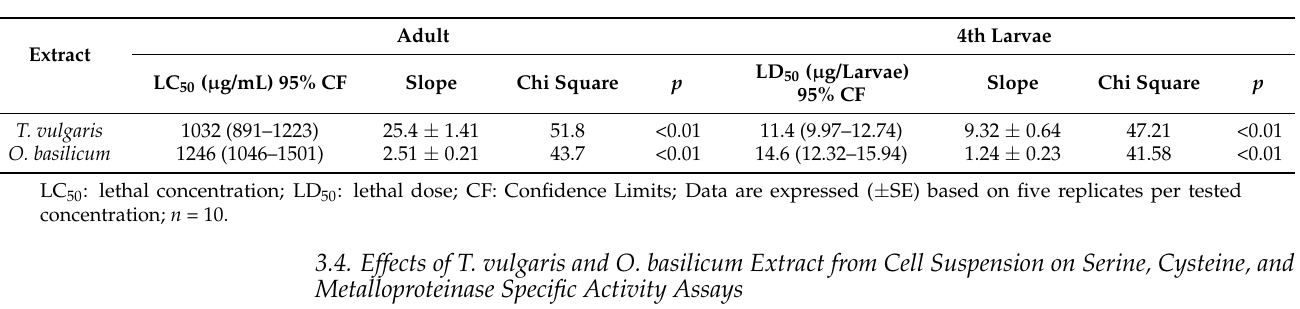
Table 3. Probit analysis of mortality for a laboratory-susceptible population of R. ferrugineus adults and 4th larvae after exposure to T. vulgaris and O. basilicum